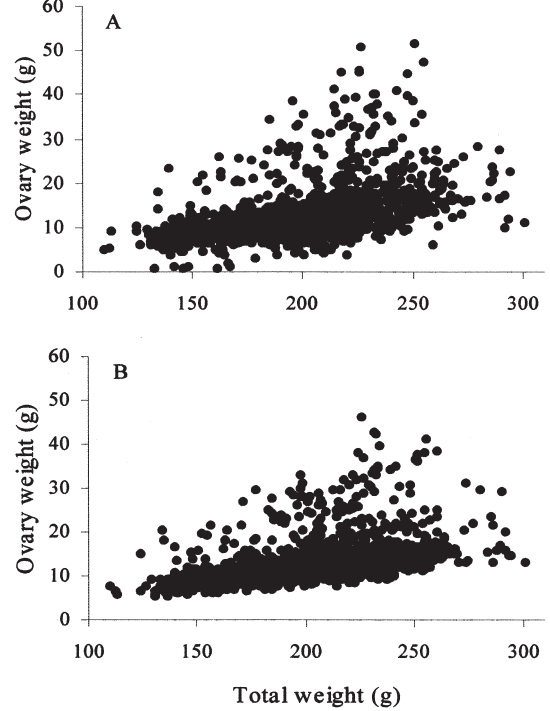
F IG . 2. – Observed (a) and estimated (b) ovary weight versus body weight for female Sardinops sagax from northern Chile. Estimated values come from Eq. 11 (see text) with estimated parameters (stan- dard errors in parentheses) q = 132.46 (9.02), p = 1.31 (0.03). r 2 = 0.72 and n = 1178. INDIRECT METHOD FOR ESTIMATING SPAWNING FRACTION 91